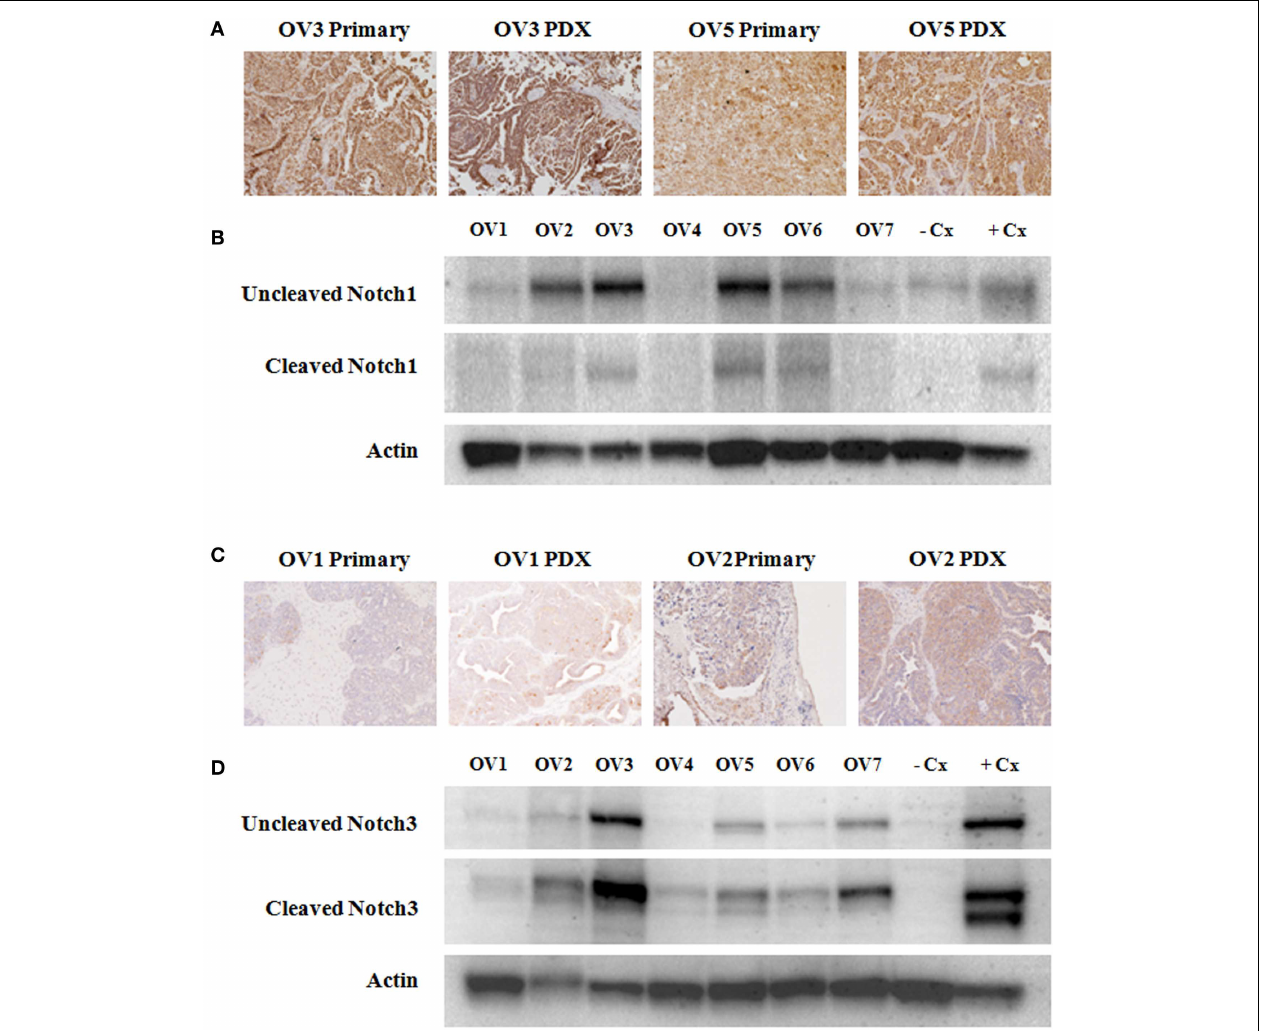
Notch1 (B) and Notch3 (D) in xenografts derived from primary human serous ovarian cancers (OV1–OV7). Uncleaved, inactivated Notch1 and Notch3 as well as cleaved activated Notch1 and Notch3 are shown. An anti-Pan-Actin antibody was used to confirm equivalent loading of samples.The HCC1187 and SKOV3 cell lines were used as a negative control ( − Cx) for Notch1 and Notch3, respectively.The MCF-7 cell line was used as a positive control ( + Cx) for both Notch1 and